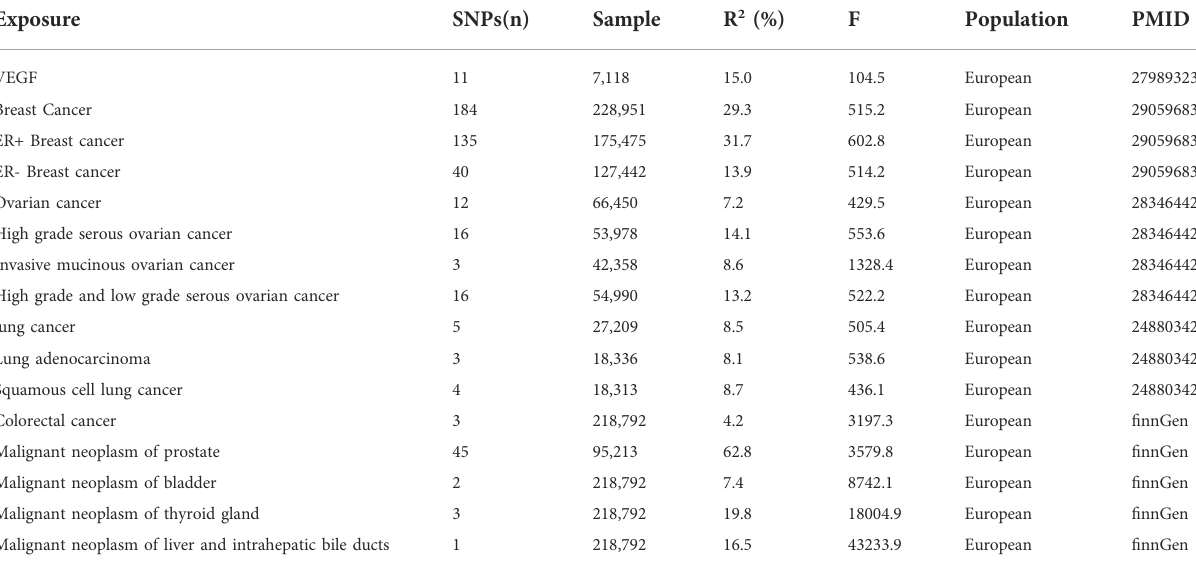
TABLE 1 Summary statistics of exposure.